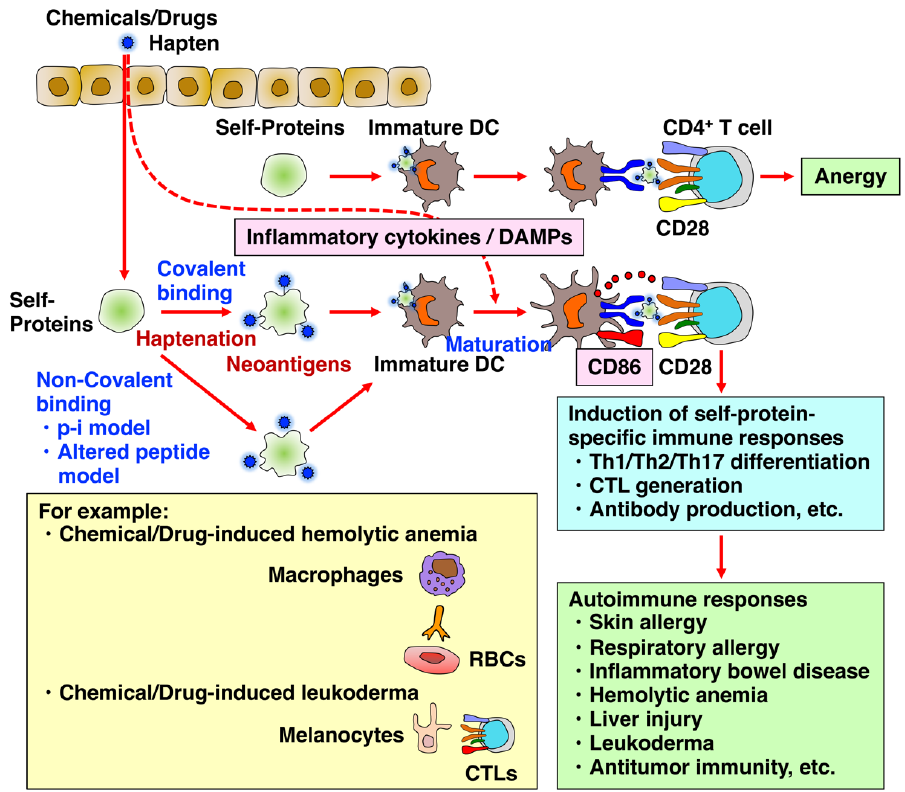
Figure 1. Chemicals and drugs induce autoimmune-like responses via haptenation, resulting in skin allergy, respiratory allergy, inflammatory bowel disease, hemolytic anemia, hepatotoxicity, leukoderma, and antitumor immunity. The upregulation of costimulatory molecule CD86 via DAMPs and inflammatory cytokines is critically important for the proper activation of naive T cells, leading to the establishment of adaptive immunity, including Th1, Th2, and Th17 differentiation; CTL generation; and antibody production. T cells activated without co-stimulation with CD86 become anergic, a state in which cells are not responsive to the stimulation thereafter and are tolerant to self-antigens. Recently, in addition to the hapten theory, non-covalent binding models such as the pharmacological interaction with immune receptors (p-i) model and the altered peptide model have also been proposed.